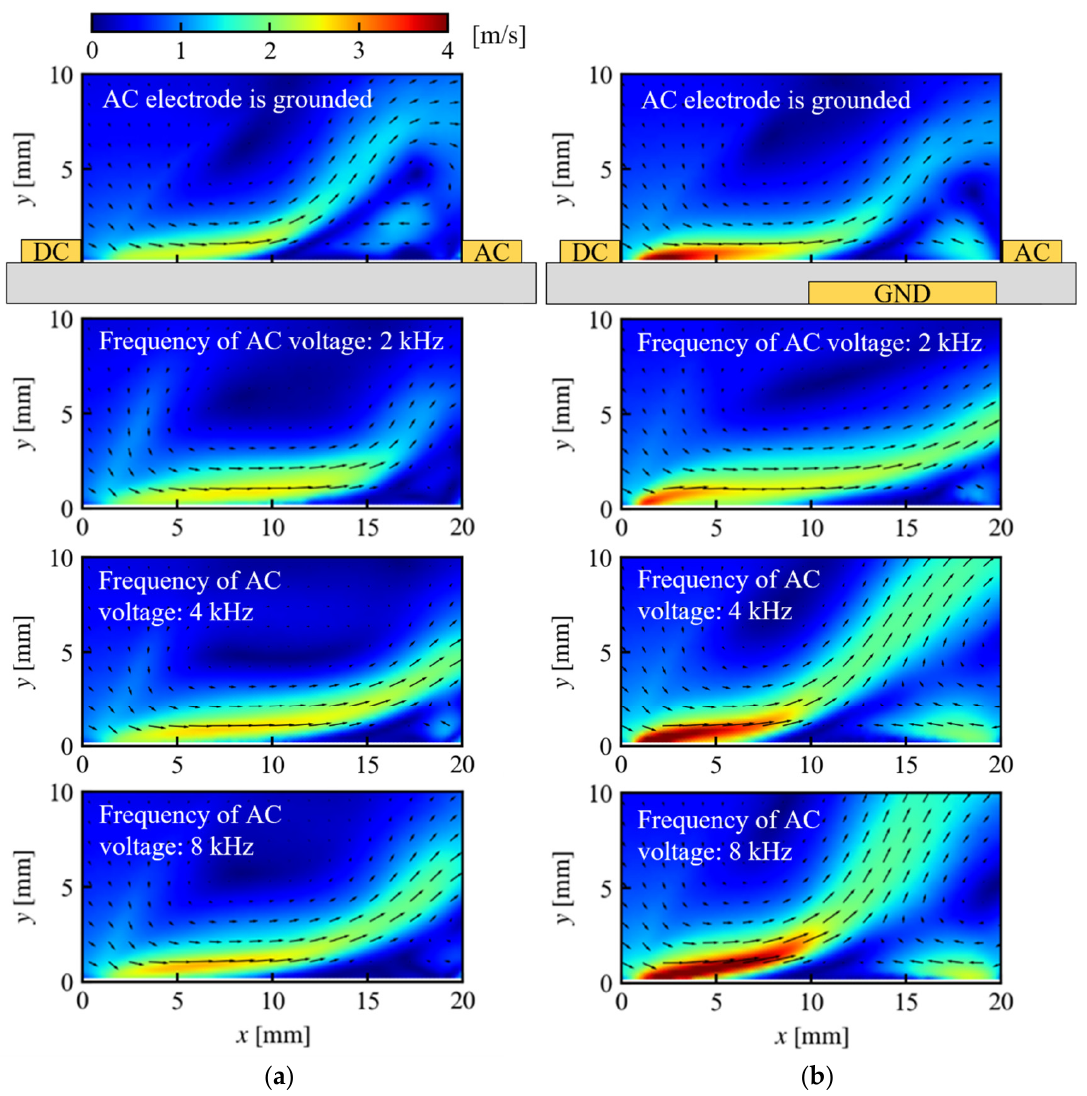
Figure 21. Flow velocity field versus the frequency of the AC voltage when the AC voltage was 10 kV pp and the DC voltage was 14 kV in the ( a ) CD-PA and ( b )